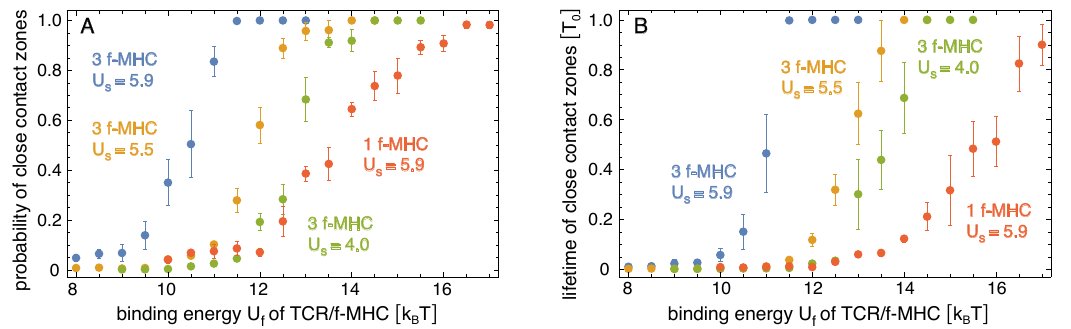
Figure 3. ( A ) Probability and ( B ) lifetime of close-contact zones in adhesion scenarios with either three or one foreign- peptide-MHC (f-MHC) versus binding energy U f of TCR/f-MHC complexes, for different values of the binding energy U s of TCR/self-peptide-MHCs in units of the thermal energy k B T . The errors are calculated as the error of the mean for six independent trajectories at each value of U f in the different simulation